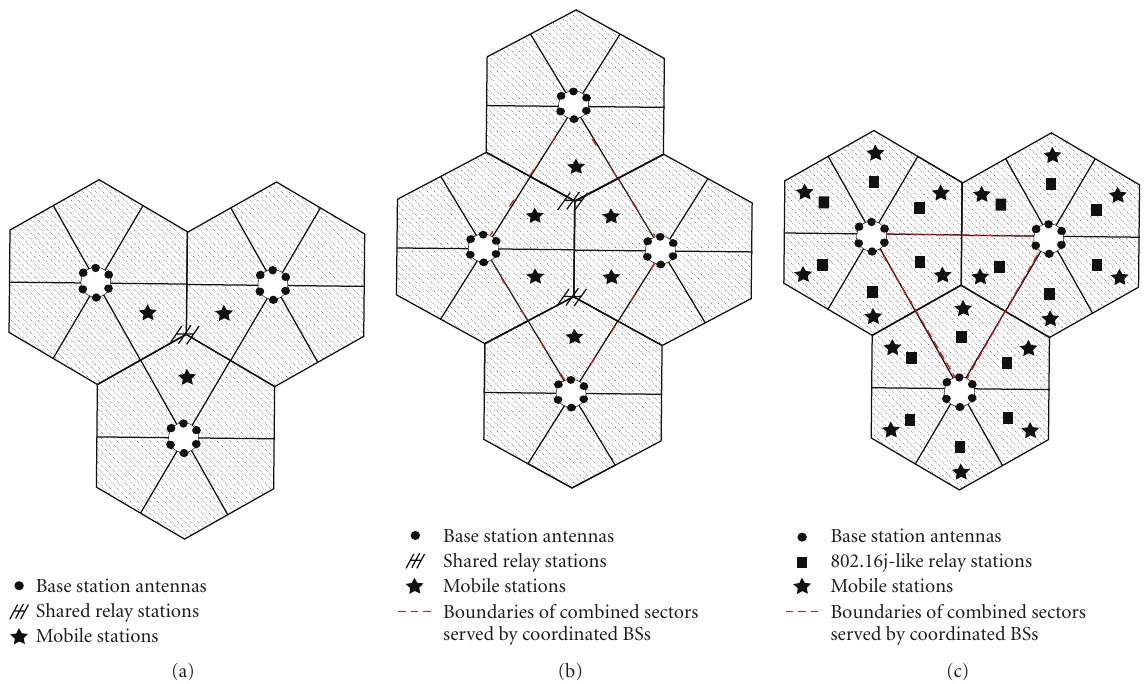
Figure 1: System models for (a) shared relaying (one-way and two-way), (b) shared relaying with BS cooperation (one-way) and (c) nonshared, 802 . 16j, relaying with BS